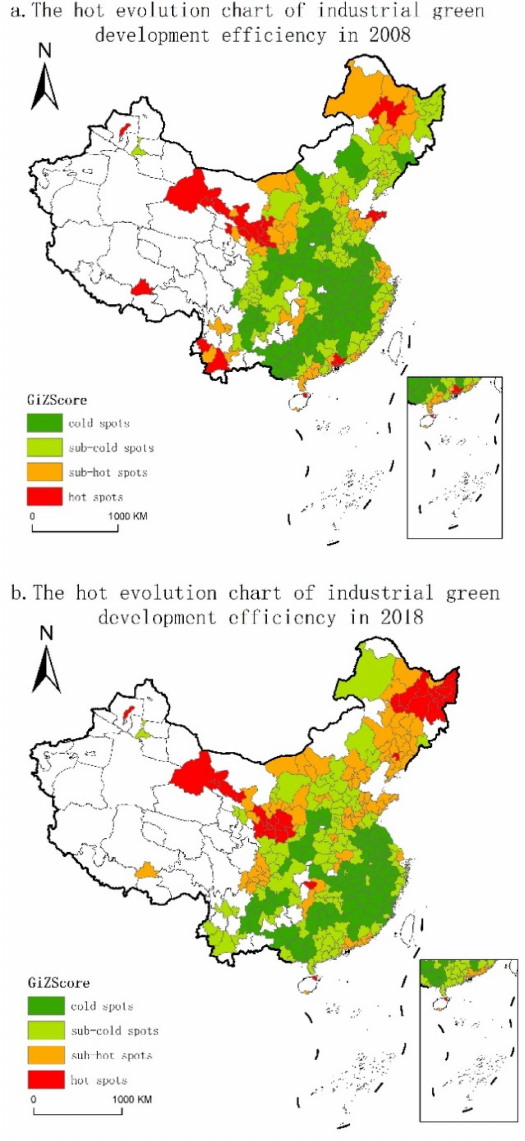
Figure 4. Cold/hot spot evolution of